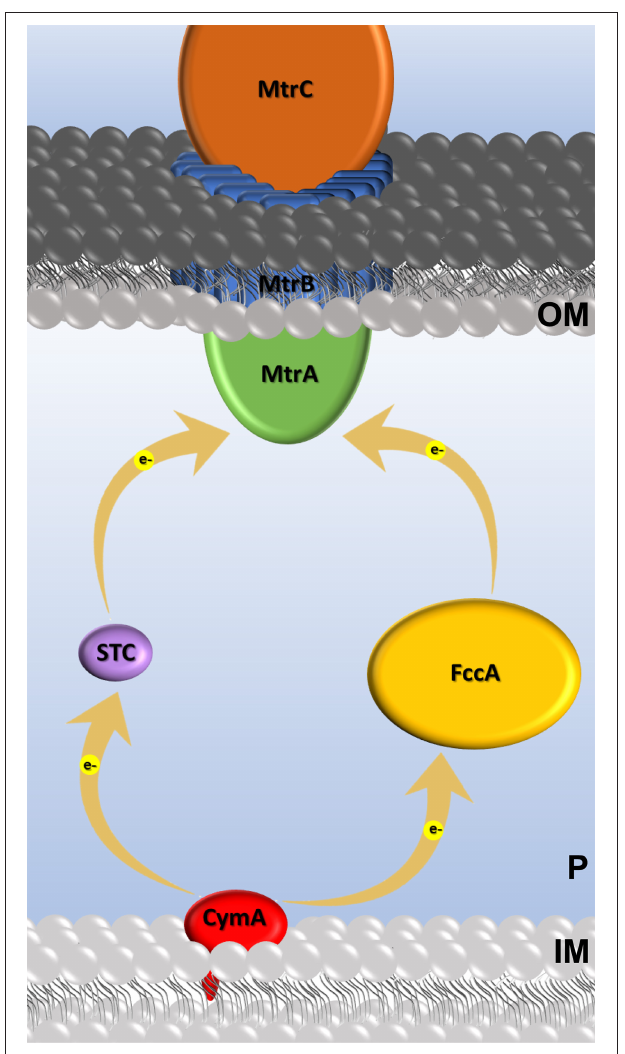
FIGURE 1 | Cartoon of the extracellular electron transfer Mtr pathway in S. oneidensis and c -type cytochromes involved. Electron transfer events are represented by yellow